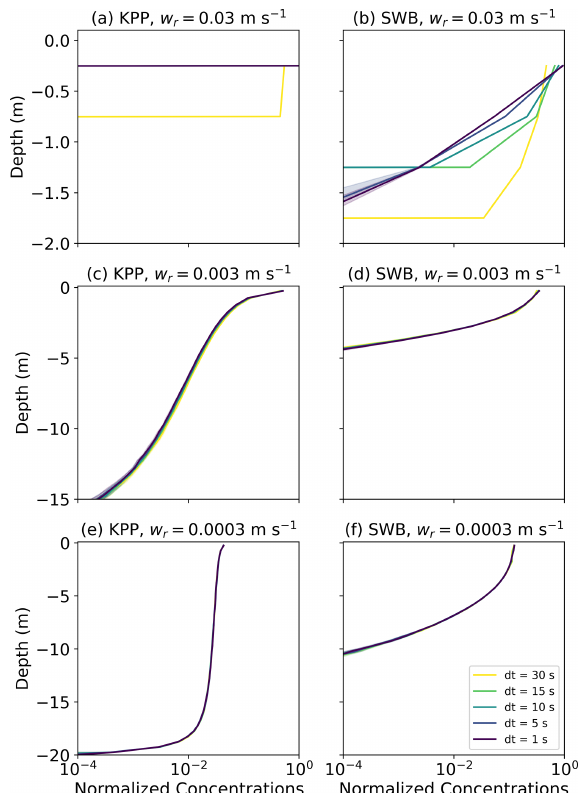
Figure G2. Vertical concentrations of buoyant particles for (a, c, e) KPP and (b, d, f) SWB diffusion using M-0 models with varying values for w rise and (cid:49)t ∈ [ 30 , 15 , 10 , 5 , 1 ] s with a reflective BC. All profiles are for u 10 = 6 . 65ms − 1 . Shading around the profiles indicates the profile’s standard deviation at each depth level. The KPP profiles are computed with θ = 1 . 0 and z 0 according to Eq. (12), while the SWB profile is computed with γ = 1 .